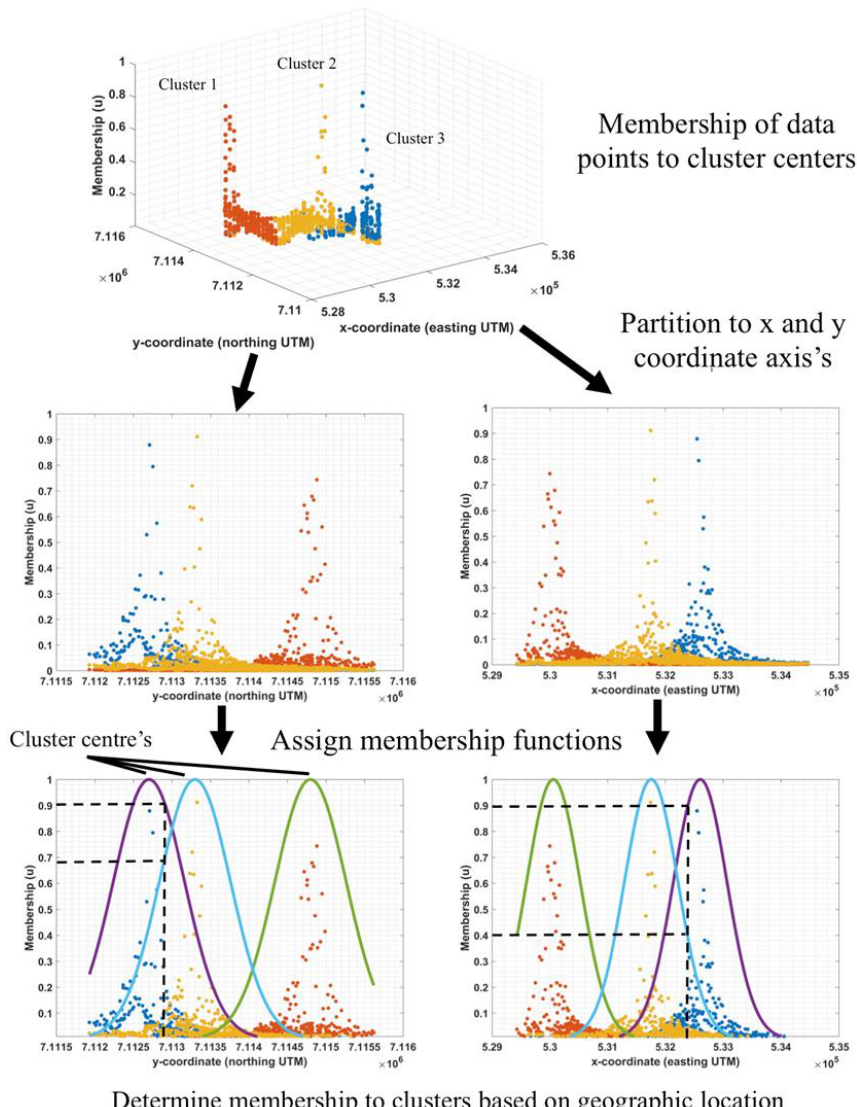
Figure 3. Example of partitioning membership to cluster centers to the map coordinate axes and applying a membership function (represented by solid lines) for three fuzzy clusters to determine membership based on geographic location.